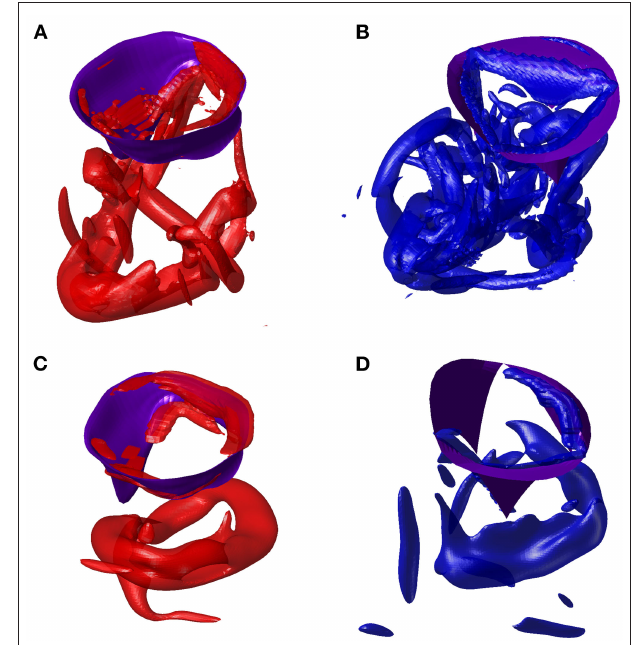
FIGURE 6 | Vortex in E-wave peak of left ventricle (LV) (A) and right ventricle (RV) (B) . Vortex in A-wave peak of LV (C) and RV (D)